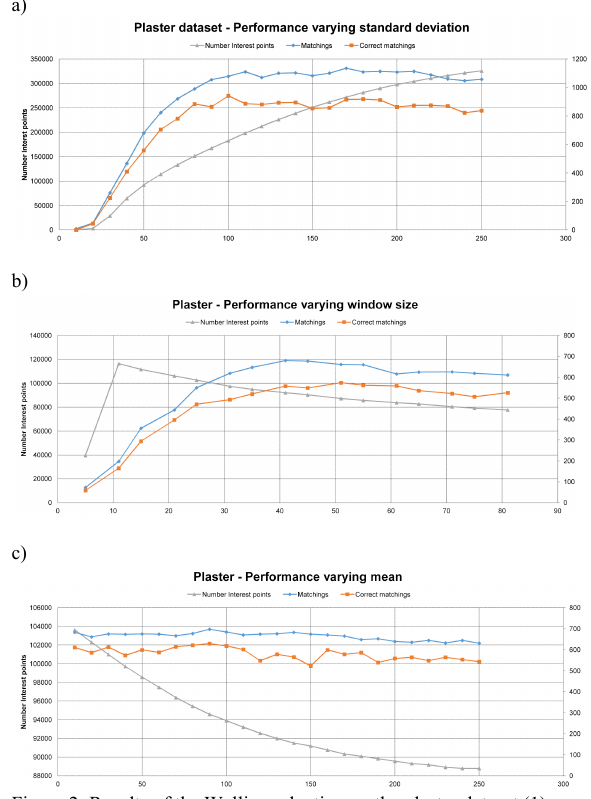
Figure 2: Results of the Wallis evaluation on the plaster dataset